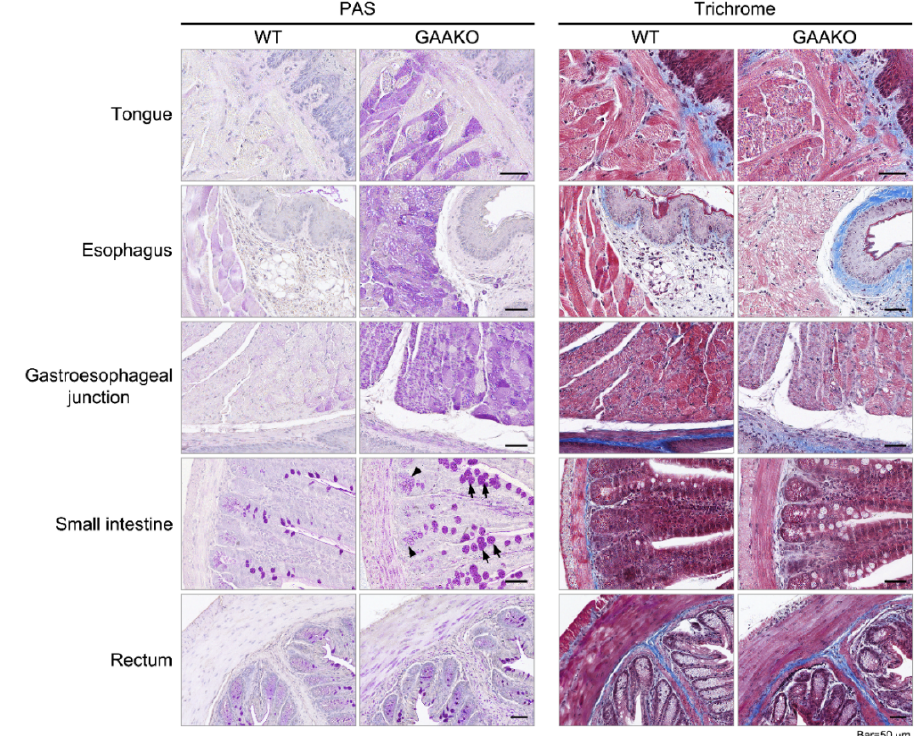
Figure 2. Periodic acid-Schiff (PAS) and Trichrome staining of the gastrointestinal tissues in Pompe mice (GAAKO), using wild type (WT) mice as controls. Extensive glycogen accumulation in the GAAKO mice, when compared to the WT mice (purple-stained skeletal muscles of the tongue and esophagus, and the smooth muscles in the esophagus, gastroesophageal junction, small intestine, and rectum). The intestinal villi (small intestine) showing hypertrophic and mild hyperplastic goblet cells (arrows) and intestinal glands (arrowheads) can be seen.